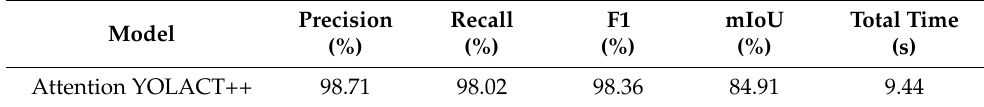
Table 1. Evaluation parameters after 400,000 iterations.